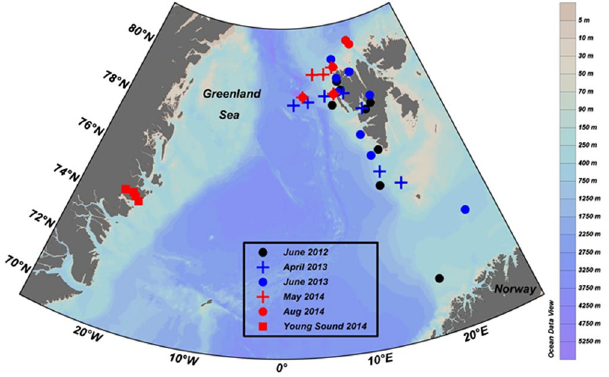
Figure 6. Location of the stations sampled. Map created with Ocean Data View software (version 4.6.3, http:// samples incubated under the incident solar radiation. Daily R light rates were corrected for those communities that were exposed to less than 24 hours of light (only five communities in September and October in Young Sound). The rates determined based on disolved oxygen changes in Young Sound, 12 out of 147 respiration rates reported here, carry considerable error, as the titration end point was determined visually, as a titrator was not available. The precision obtained (expressed as SD of average in %) for O 2 concentration measurements with this procedure was 0.15%. Per each depth, a set of seven replicated 100-mL narrow-mouth Winkler bottles was fixed immediately to evaluate the initial oxygen content, and two sets were incubated under light and dark conditions for 24 hours. Incubations were done in water baths on deck (maintained at the in situ temperature of the surface water, ± 1 °C, through continuous water flow from the surface) in Svalbard; and in situ in Young Sound. Neutral screens were used to reduce incident irradiance as to mimic the light environment in situ . Dissolved oxygen concentrations were determined by automated high-precision Winkler titration with a potentiometric end-point Metrohm 808 Titrando 28 in the Svalbard communities and using starch as indicator for end-point detection in the Young Sound communities. R dark and NCP were calculated from changes in dissolved oxygen concentrations, before and after incubation of samples under “dark” and “light” conditions, respectively, for 24 h in Svalbard and 48 h in Young Sound. As a consequence of the low rates and low precision of dissolved oxygen determination in Young Sound, the communities were incubated for 48 h, thereby experiencing changes that could be resolved with the tech- niques used there. On the other hand, long incubations may increase the risk of artifacts derived from bottle effects. Rates are reported in µ mol O 2 L − 1 d − 1 and standard errors were calculated using error propagation. In order to compare the R light :R dark ratios obtained here with those observed in the past, we surveyed the literature for results reported in the past 6, 7, 16–18, 27 . An extreme value reported by one of the studies 7 (ratio R light :R dark = 19), 8-fold higher than the rest, was excluded from the comparison. For evaluation of GPP 18 O, eight 12-ml glass vials were filled per depth. Four replicate samples were immedi- ately fixed (biological activity stopped) with 80 µ l of saturated HgCl 2 solution for later analysis of initial δ 18 O(O 2 ) values, and stored upside down in darkness. The other four vials, containing beads inside to ensure mixing, were spiked with 80 µ l and 200 µ l of 98% H 218 O in Svalbard and Young Sound communities, respectively. After being closed, these spiked vials were immediately agitated, to ensure that H 2 18 O was homogeneously distributed inside the vial. The spiked samples were incubated together with the Winkler bottles under “light” conditions. After the 24-hour incubation, vials were fixed with 80 µ l of saturated HgCl 2 solution and stored upside down in darkness. At the stable isotope laboratory, a 4-ml headspace was generated in each vial, by flushing with a helium flow. The vials were left for equilibration at room temperature for 24 hours. The δ 18 O of dissolved oxygen in the head- space was measured in a Finnigan GasBench II attached to a Finnigan DeltaPlusXP isotope ratio mass spectrome- ter, with precision better than 0.1‰. δ 18 O-H 2 O of spiked samples was measured in a liquid water isotope analyzer (Los Gatos Research), with precision of 0.1‰, and GPP 18 O was calculated 22 . Statistical analysis were based on non-parametric tests (Wilcoxon signed rank test, Kruskal-Wallis test and Dunn’s test), as the data were skewed and not normally distributed, or log-transformed to homogenize the vari- ance prior to fitting least squares linear regression equations.